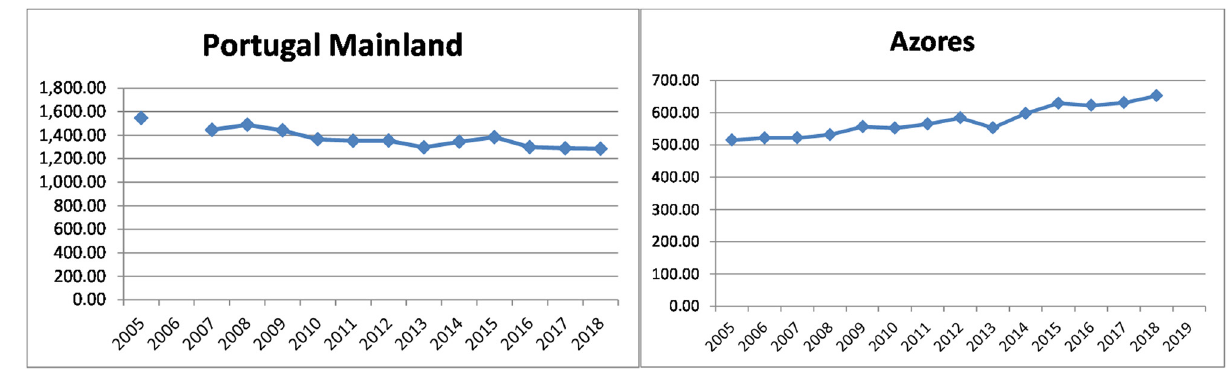
Figure 6: Production of cow ’ s milk on farms for Portugal ’ s Mainland and the Azores.